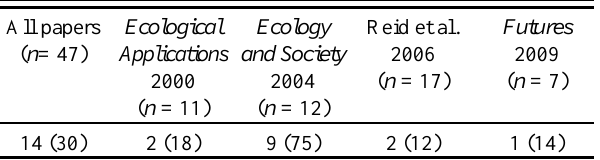
Table 4. Number of papers in reviewed literature that discuss relationship between knowledge integration and resilience, identified by manual search. (% of